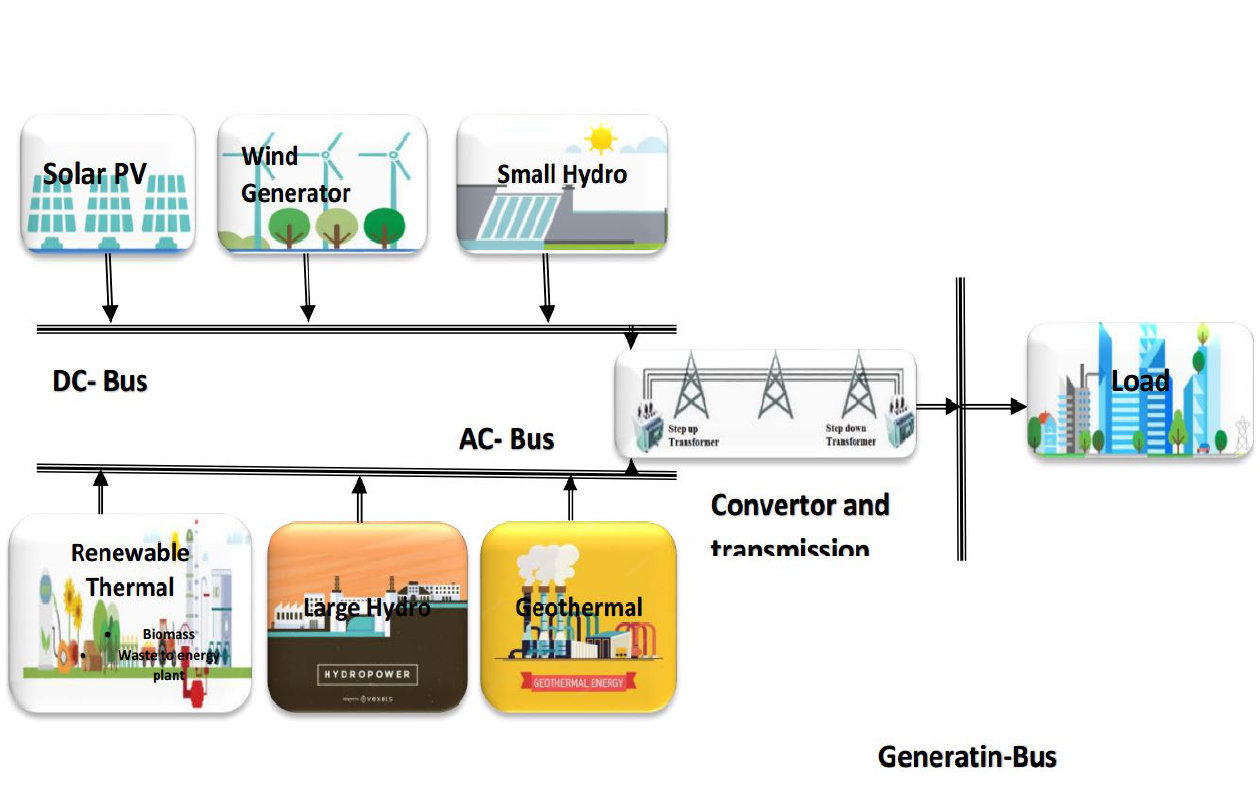
Figure 1. Proposed schematic diagram of